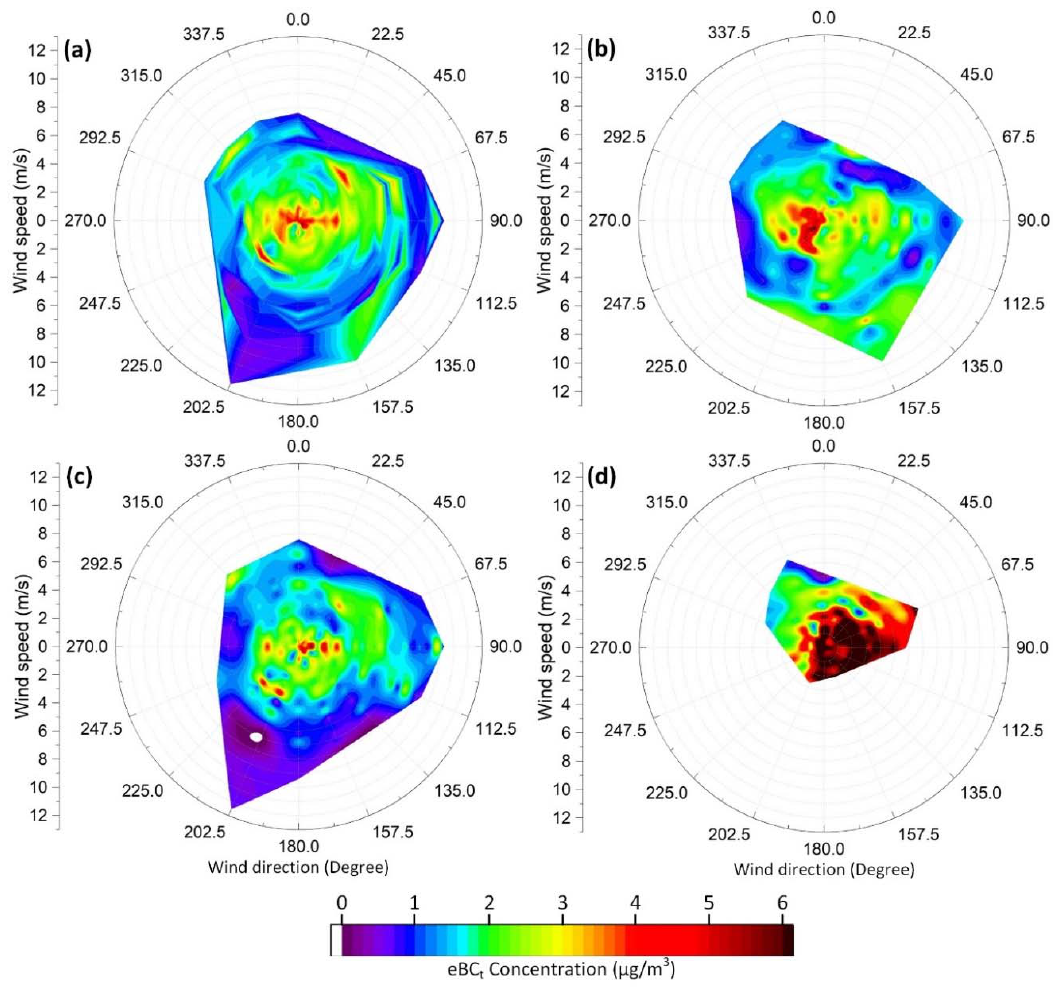
Figure 5. Bivariate polar plots demonstrating the effect of wind direction and wind velocity on measured eBC t concentrations during: ( a ) the whole study, ( b ) Pre ‐ LD, ( c ) LD, and ( d ) Post ‐ LD periods.